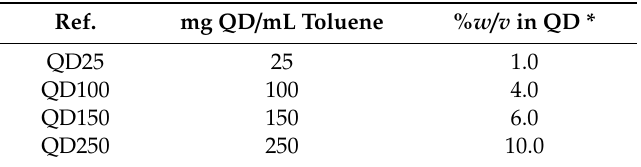
Table 1. Quantum dot (QD) concentrations along with their values in % w / v .